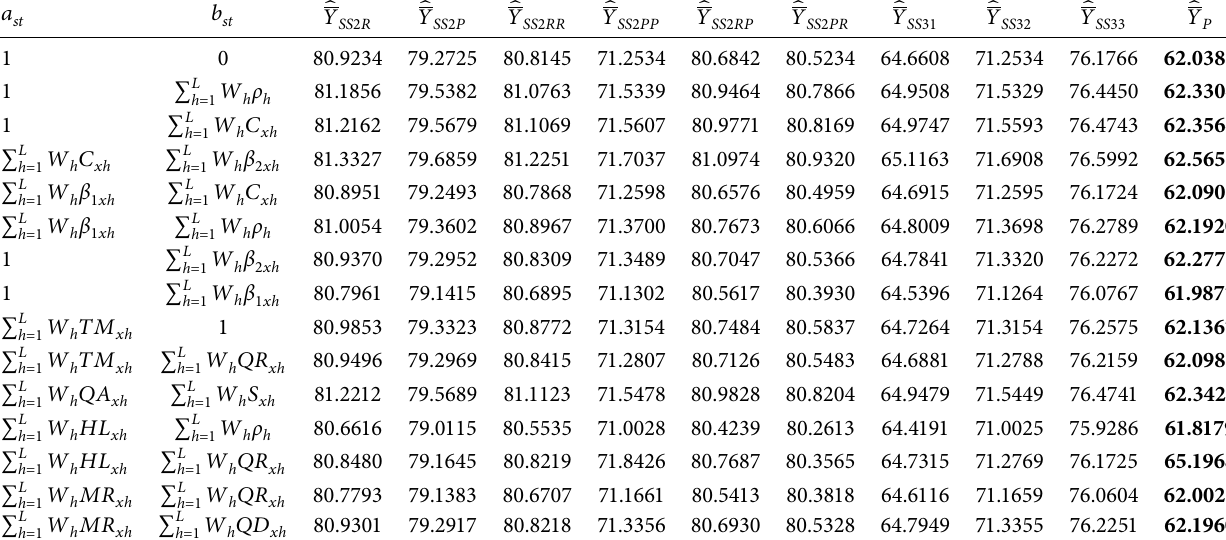
Table 11: Minimum MSEs of different estimators based on the simulation study ( n �